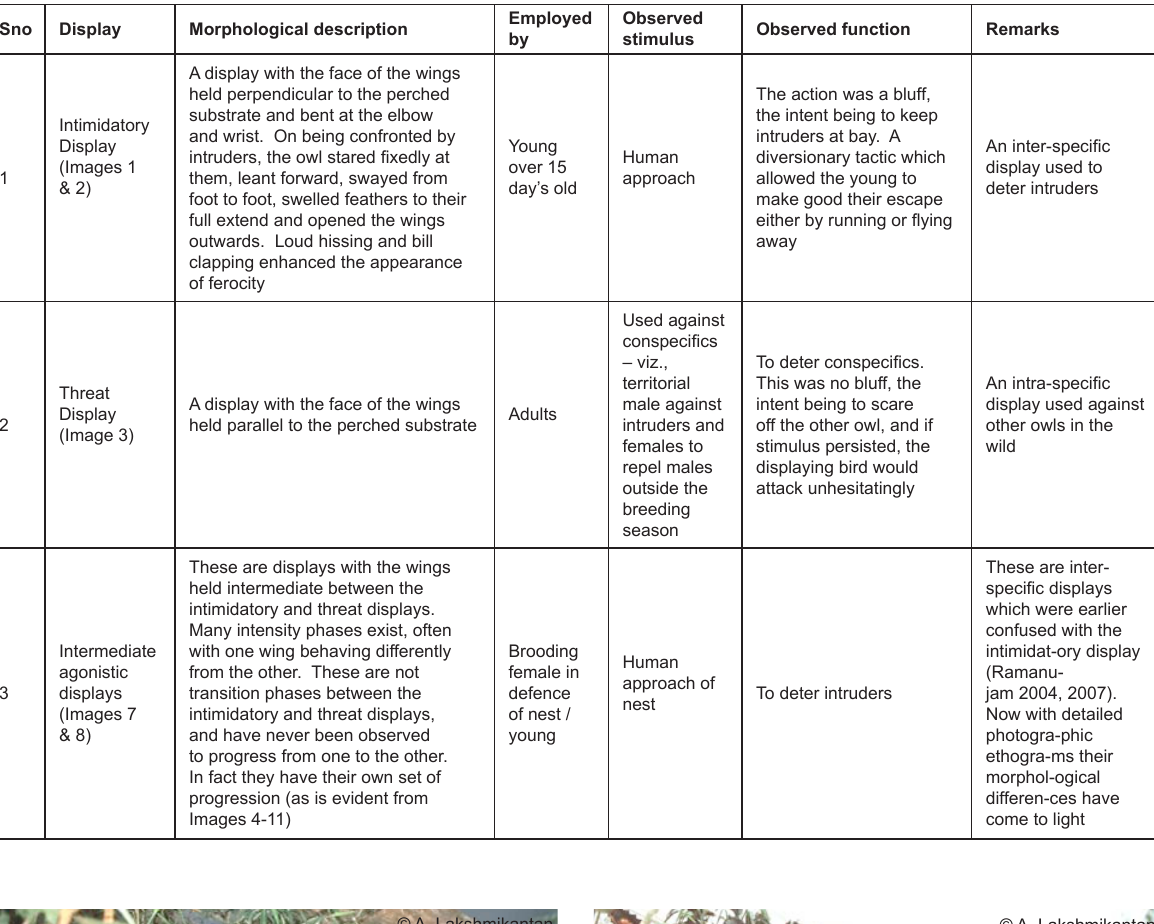
Table 1. The observed spread-winged displays of Bubo bengalensis in the wild